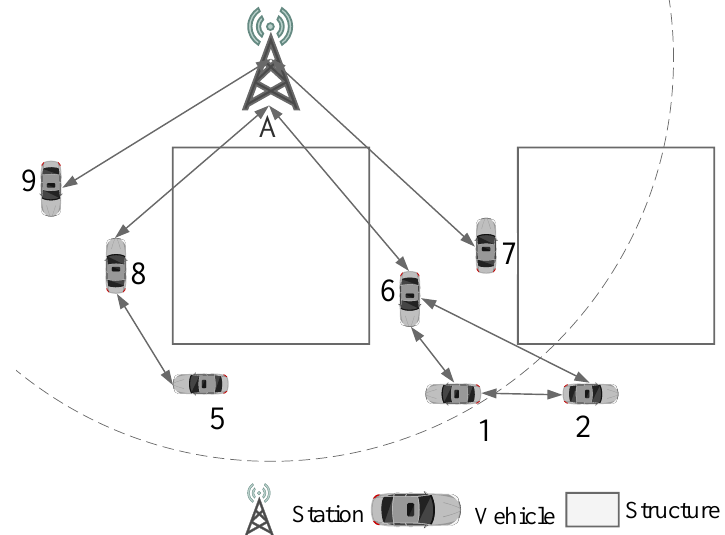
Figure 5. Illustration of Base Station Broadcast Coverage and Assisted